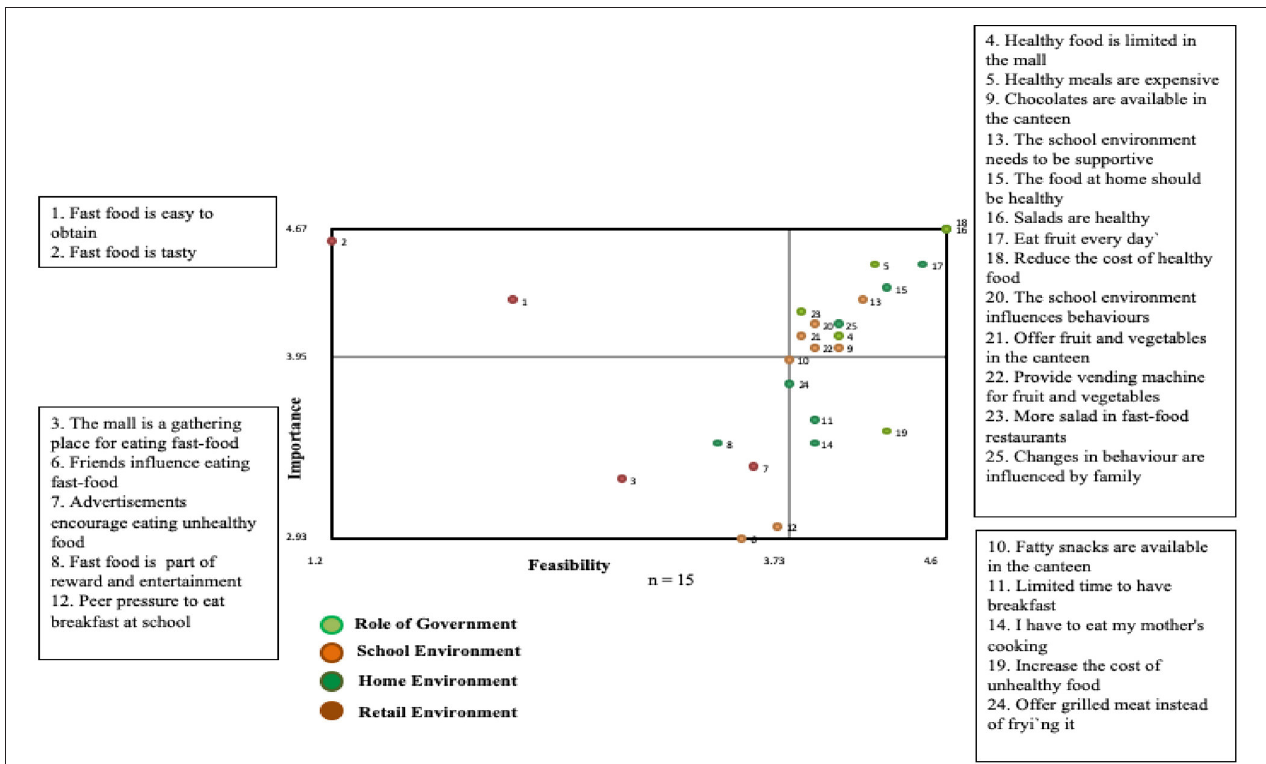
FIGURE 1 | Go-zone map based on students’ perspectives on the factors that influence their dietary